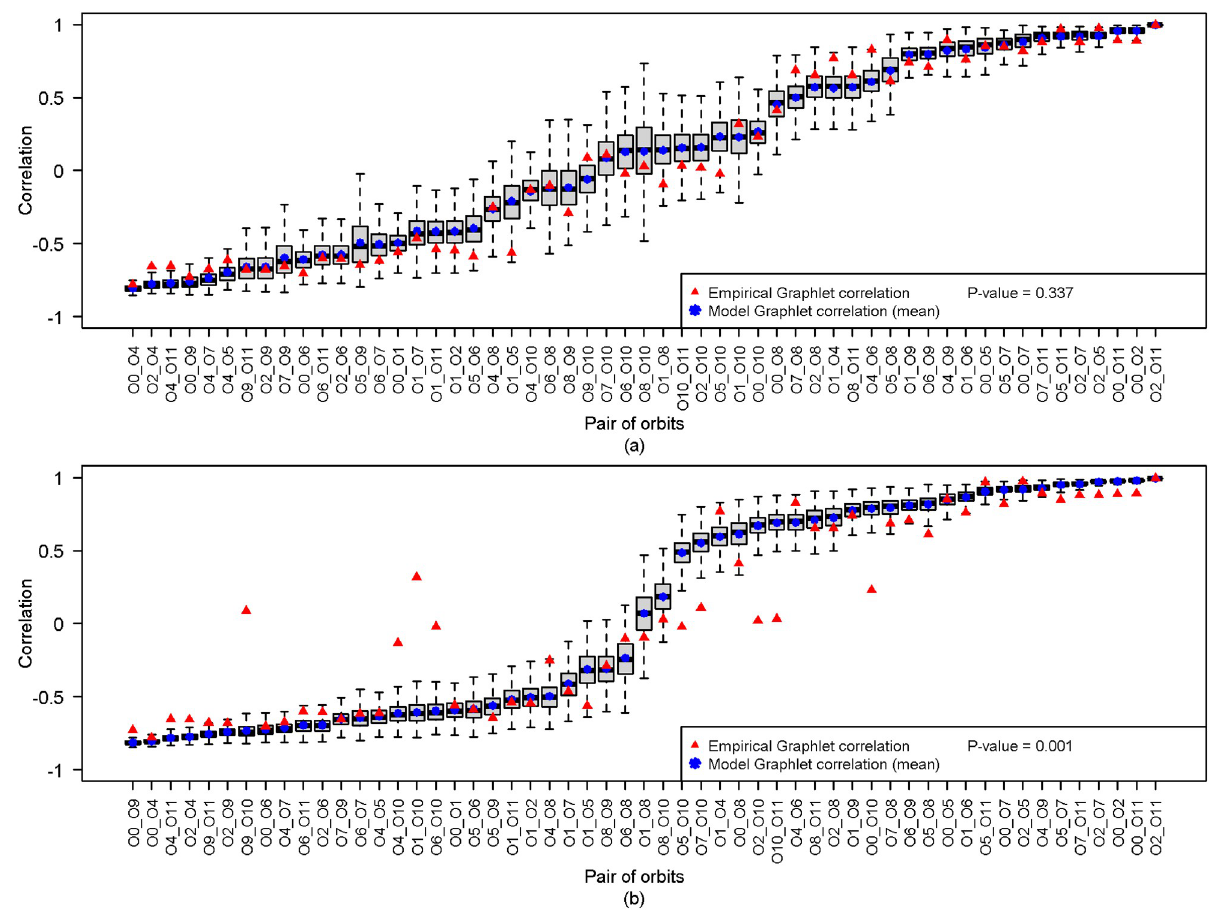
Fig 6. Comparison between graphlet correlation coefficient of empirical and random graph model. (a) Graph 10 and Geometric model (b) Graph 10 and Erd ő s-Re´nyi model. For each pair of orbits, the graphlet correlation coefficients of 1000 Erd ő s-Re´nyi or Geometric graphs are presented as a boxplot with the mean value (blue asterisk) and the empirical value (red triangle). The correlation coefficients are mostly different from Erd ő s-Re´nyi graphlet correlation coefficients. Conversely, there is a strong similarity between graphlet correlation coefficients from Geometric graphs.